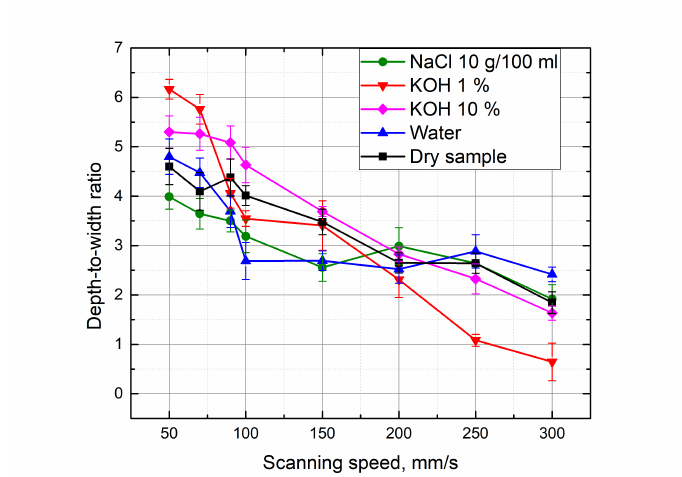
Figure 10. Depth-to-width ratio of the grooves formed in different media depending on the scanning